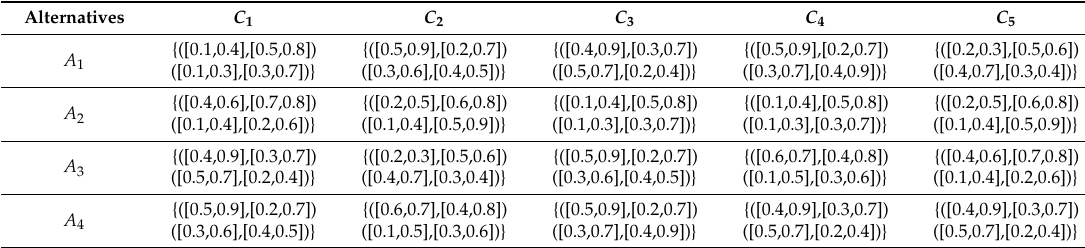
Table 2. The interval-valued intuitionistic hesitant fuzzy decision matrix for decision maker